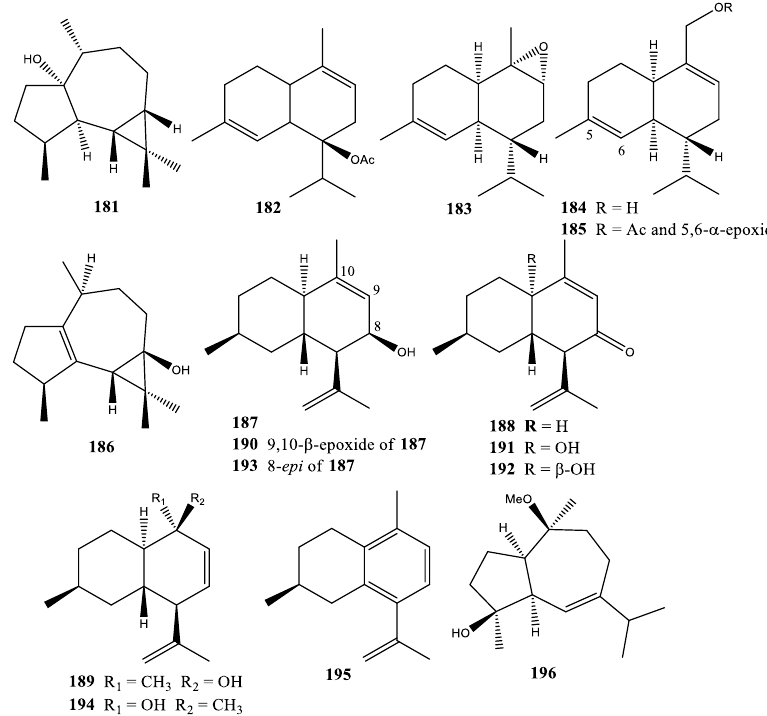
Figure 9. Structures of compounds 181 – 196 .